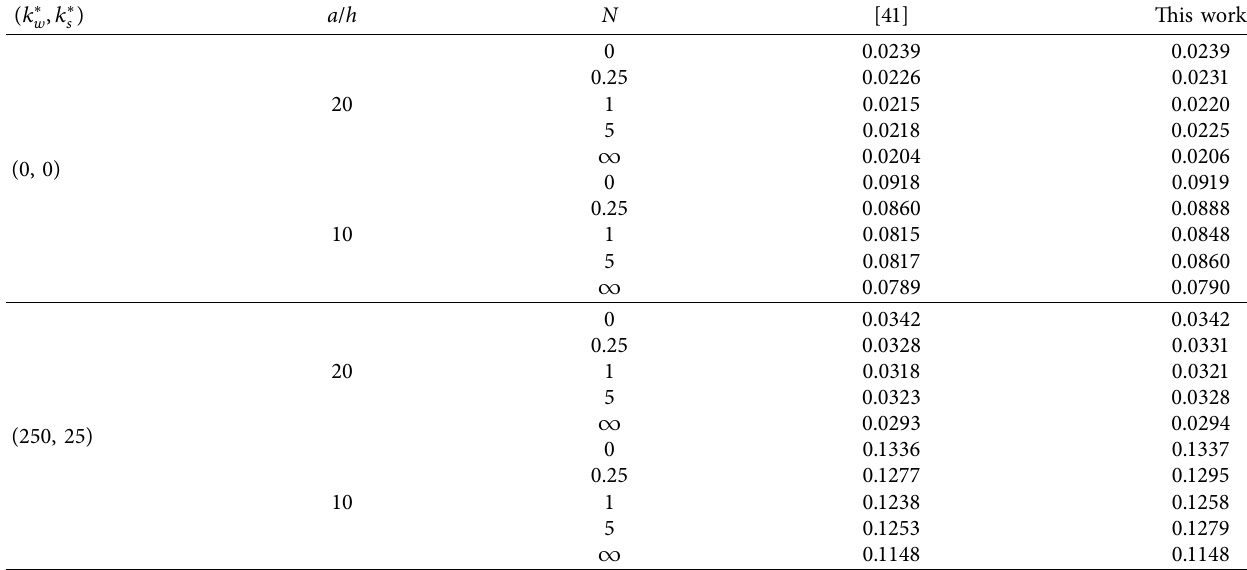
Table 3: Comparison of first nondimensional natural frequencies ϖ of fully simply supported FGM plates resting on two-parameter elastic